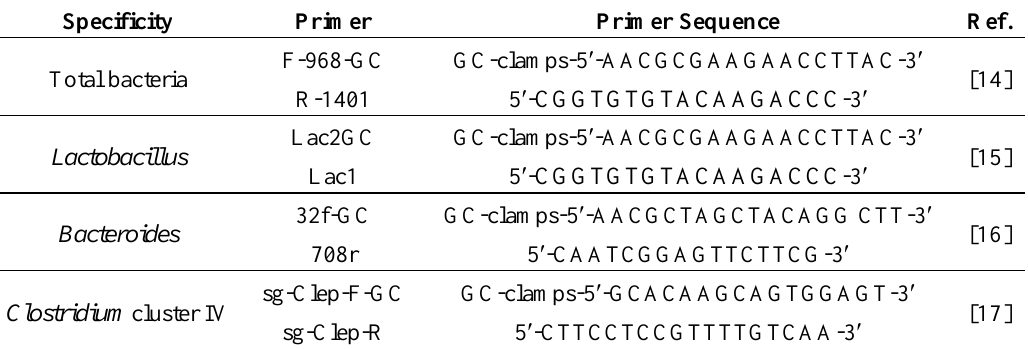
Table 1. Primers for PCR amplification of different bacterial